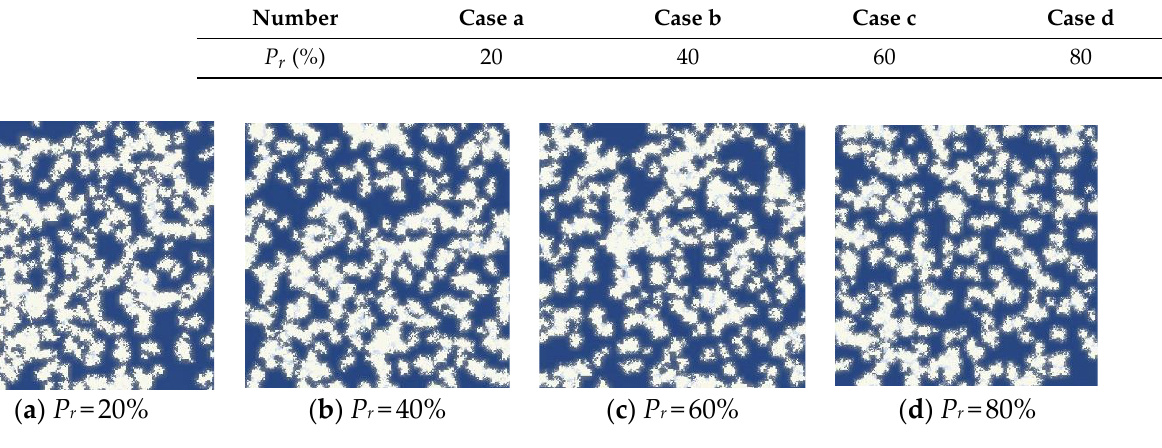
Figure 8. Calculation model of C-S-H.